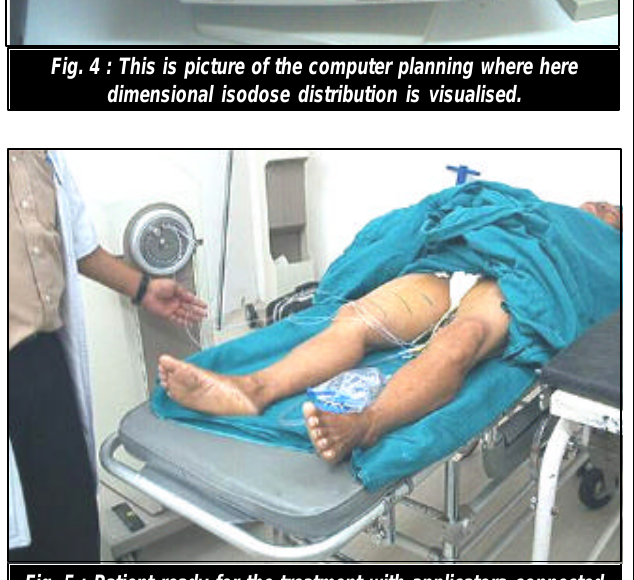
Fig. 1 : This picture is showing FSD applicator used for brachytherapy treatment of cancer of cervix.